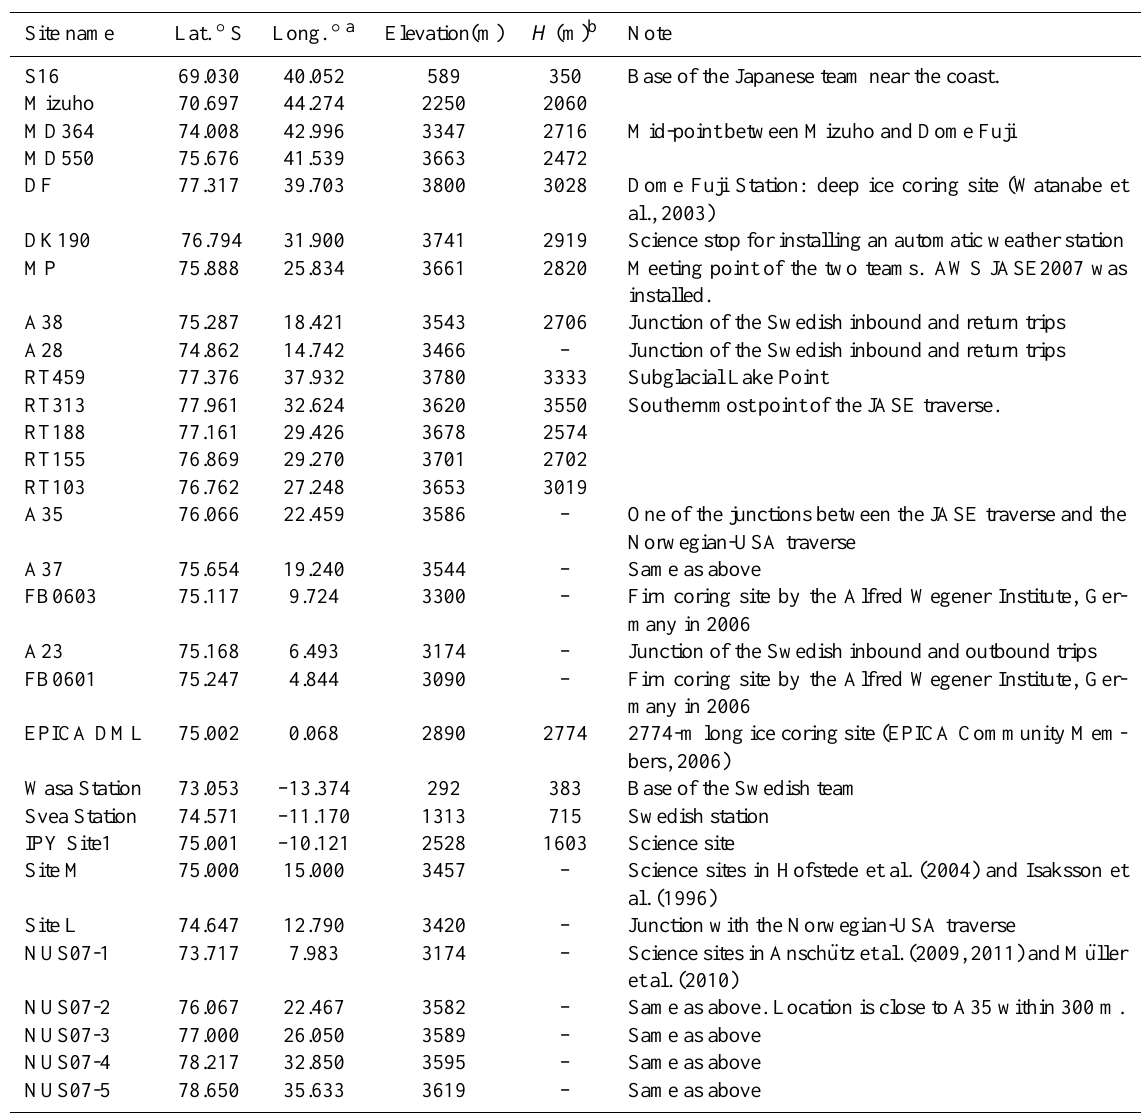
Table 1. Major sites along the JASE traverse and related